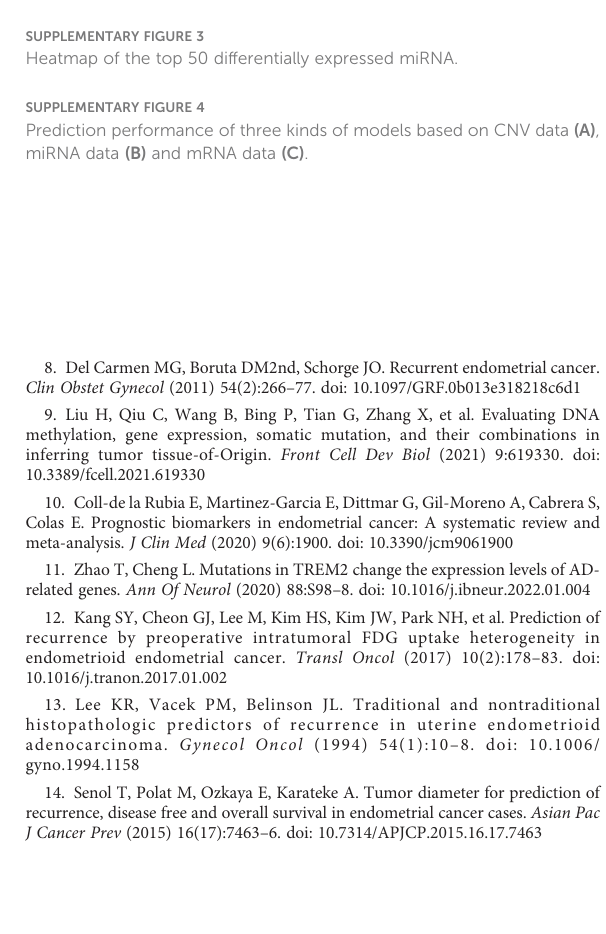
Heatmap of the top 50 differentially expressed lncRNA.